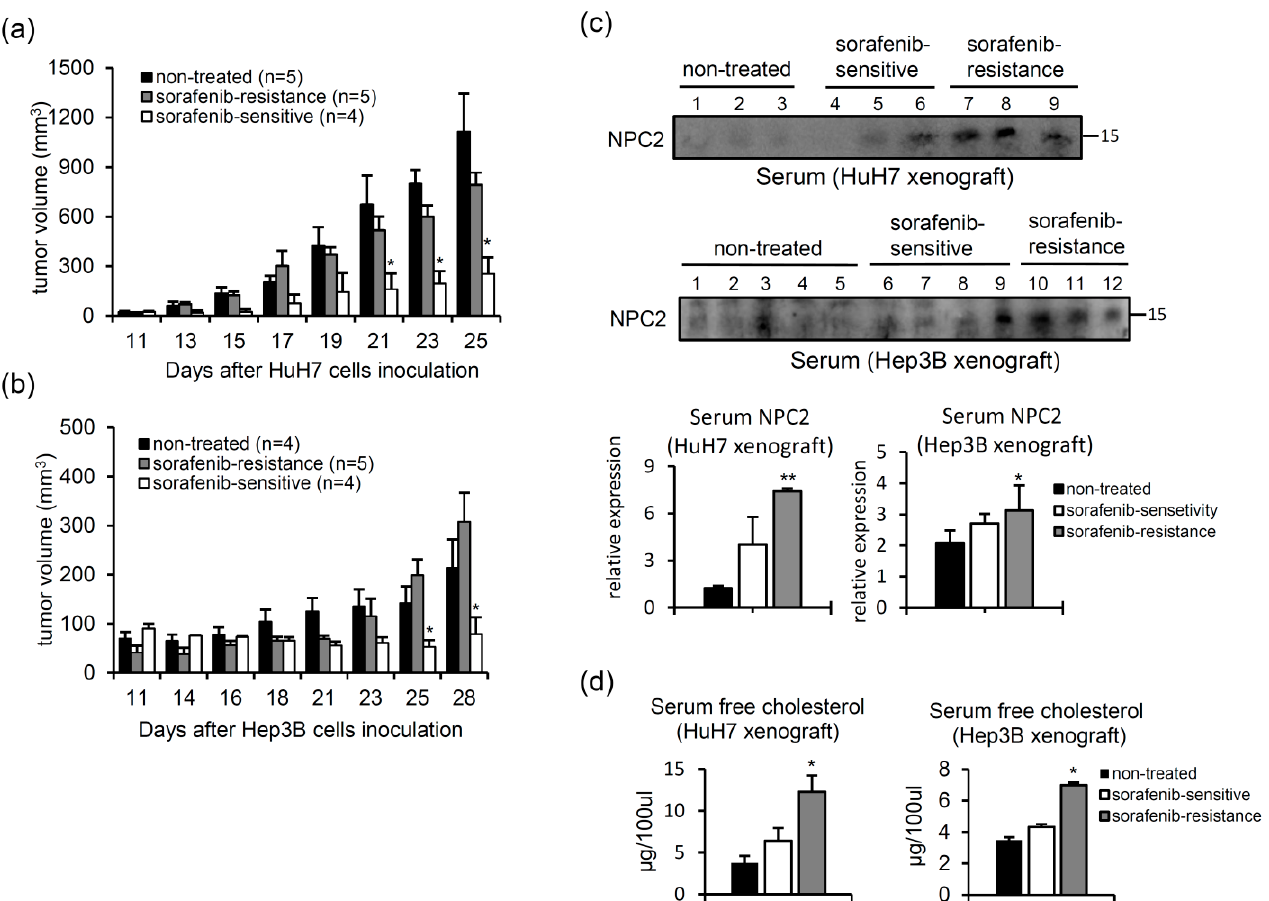
Figure 7. Serum levels of Niemann-Pick type C2 (NPC2) and free cholesterol increase in xenografts with acquired sorafenib resistance. ( a , b ) HuH7 and Hep3B cells were subcutaneously injected into NOD/SCID mice, and sorafenib was intraperitoneally injected every day. The mean tumor volume ± SEM at the indicated time is shown. The growth of sorafenib-treated tumors can be divided into two patterns: sorafenib sensitive (white bar) and a lack of response to sorafenib (gray bar, sorafenib resistance). ( c ) Western blot images and quantification of serum NPC2 are shown. Each line was loaded with 100 μ g of protein. ( d ) Serum levels of free cholesterol. * p < 0.05, ** p < 0.01 compared to the black bar.